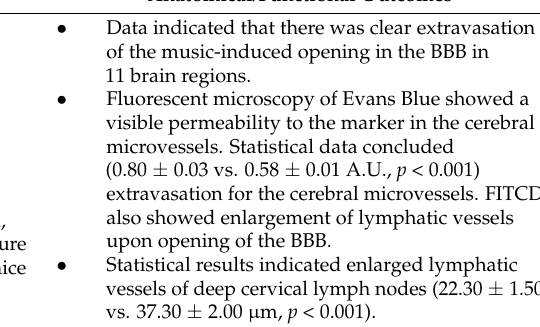
[28] Phenomenon of music-induced opening of the blood–brain barrier in healthy